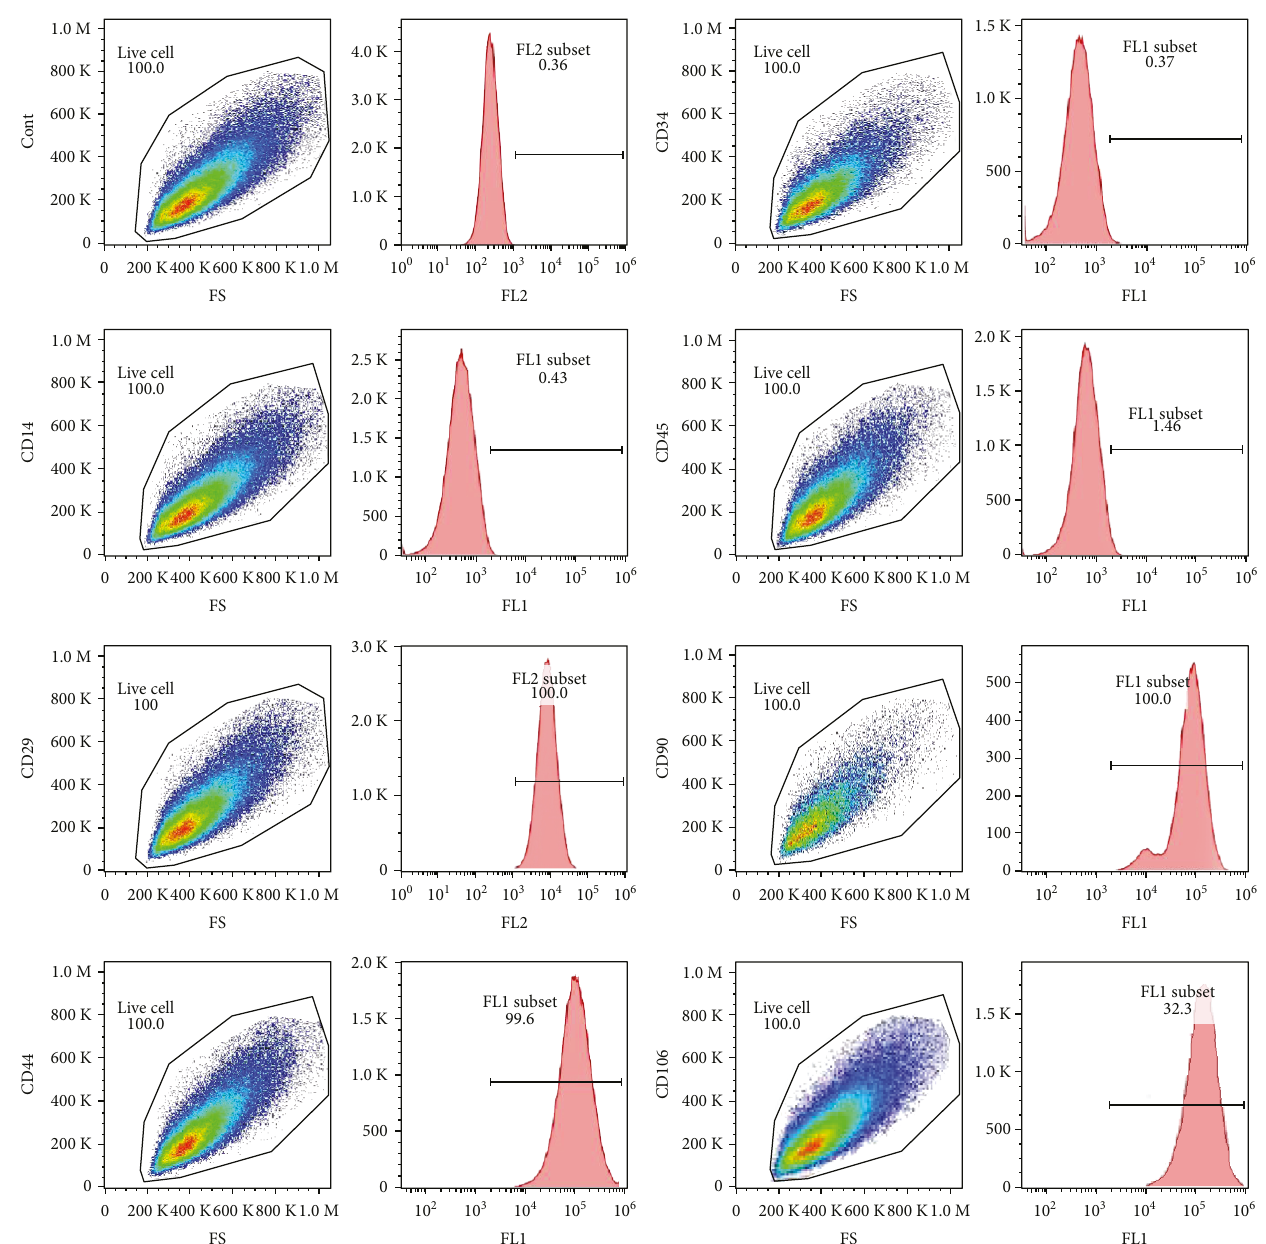
Figure 1: Identi fi cation of stem cell-related cell surface markers on hBMMSCs. Detection of cell surface markers was characteristic of mesenchymal stem cells on the three cells. Analyses were performed via fl ow cytometry, detecting PE- or FITC-conjugated monoclonal antibodies for human CD29, CD44, CD90, CD106, CD14, CD34, CD45, or isotype-matched control IgGs. Cont: